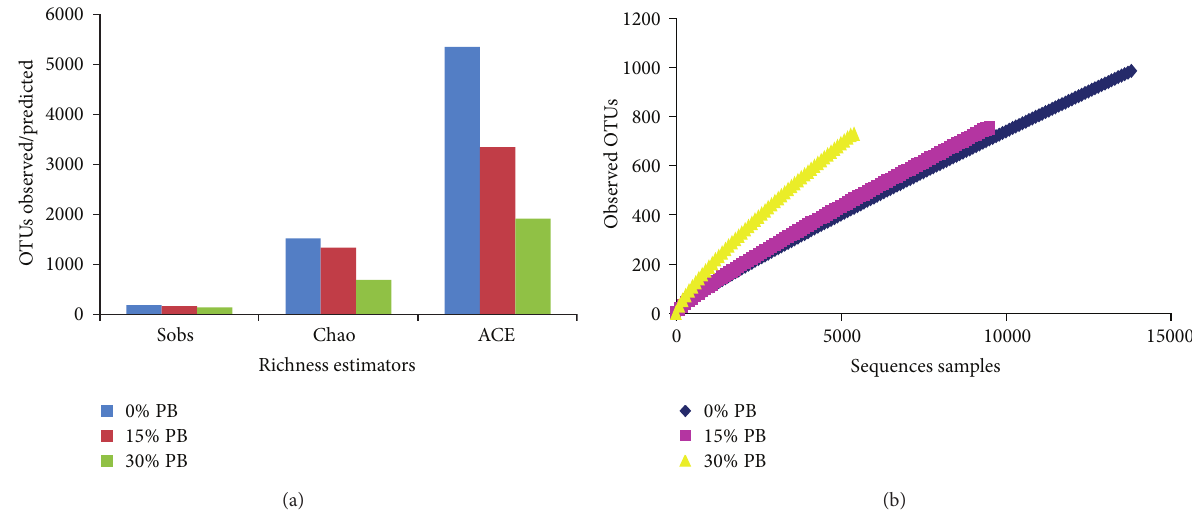
Figure 2: Fecal archaea richness/diversity estimator (a) and rarefaction curves (b) presented as calculated by MOTHUR at a level of 3% dissimilarity. 0% PB (control), 15% PB, and 30% PB on an as-fed basis.